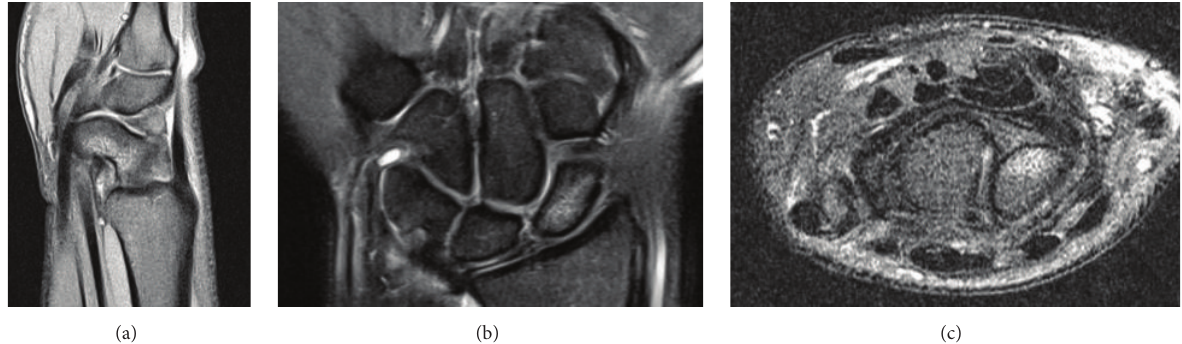
Figure 4: (a) A 1.5-Tesla MRI T2 sagittal cut demonstrating palmar scaphoid waist bone edema consistent with incomplete scaphoid waist stress fracture obtained at the time of initial presentation. (b) A 1.5-Tesla MRI T2 coronal cut showing scaphoid waist bone edema consistent with incomplete scaphoid waist stress fracture obtained at the time of initial presentation. (c) A 1.5-Tesla MRI T2 axial cut showing palmar scaphoid waist bone edema consistent with incomplete scaphoid waist stress fracture obtained at the time of initial presentation.